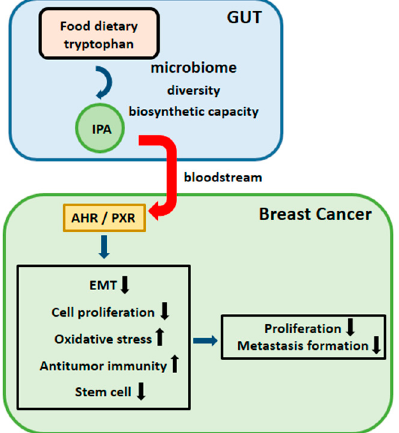
ff ects to breast cancer